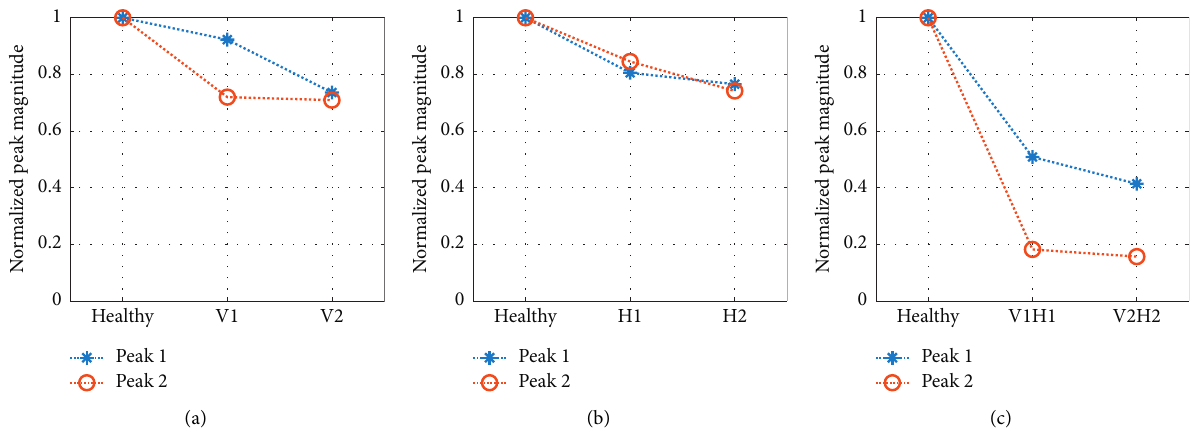
Figure 19: Shifts in peak magnitudes caused by PZT debonding defects. (a) Cases: V1, V2. (b) Cases: H1, H2. (c) Cases: V1H1, V2H2.